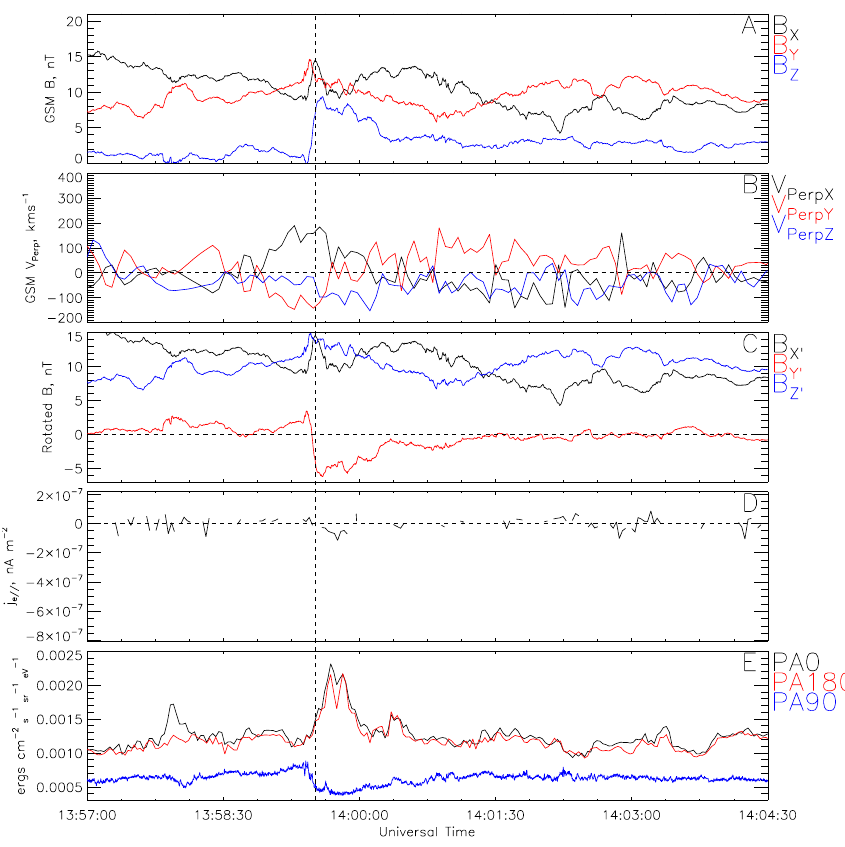
Fig. 12. Data pertaining to the entry of C4 into the plasma bubble. Panel (A) shows GSM components and magnitude of magnetic field, panel (B) the GSM components of V ⊥ , panel (C) the magnetic field rotated about GSM X into a coordinate frame that eliminates any Y component in the undisturbed magnetic field, in order to identify any draping in the field around the plasma bubble. Panel (D) is the parallel electron current calculated from 2-D pitch angle distributions in the energy range covered by both PEACE sensors. Panel (E) shows the electron differential energy fluxes separately for 0 ◦ PA, 180 ◦ PA and 90 ◦ PA, taken from 3-D distributions returned by both the HEEA and LEEA sensors and summed over their common energy range. The vertical dashed line marks the entry of the spacecraft into the plasma